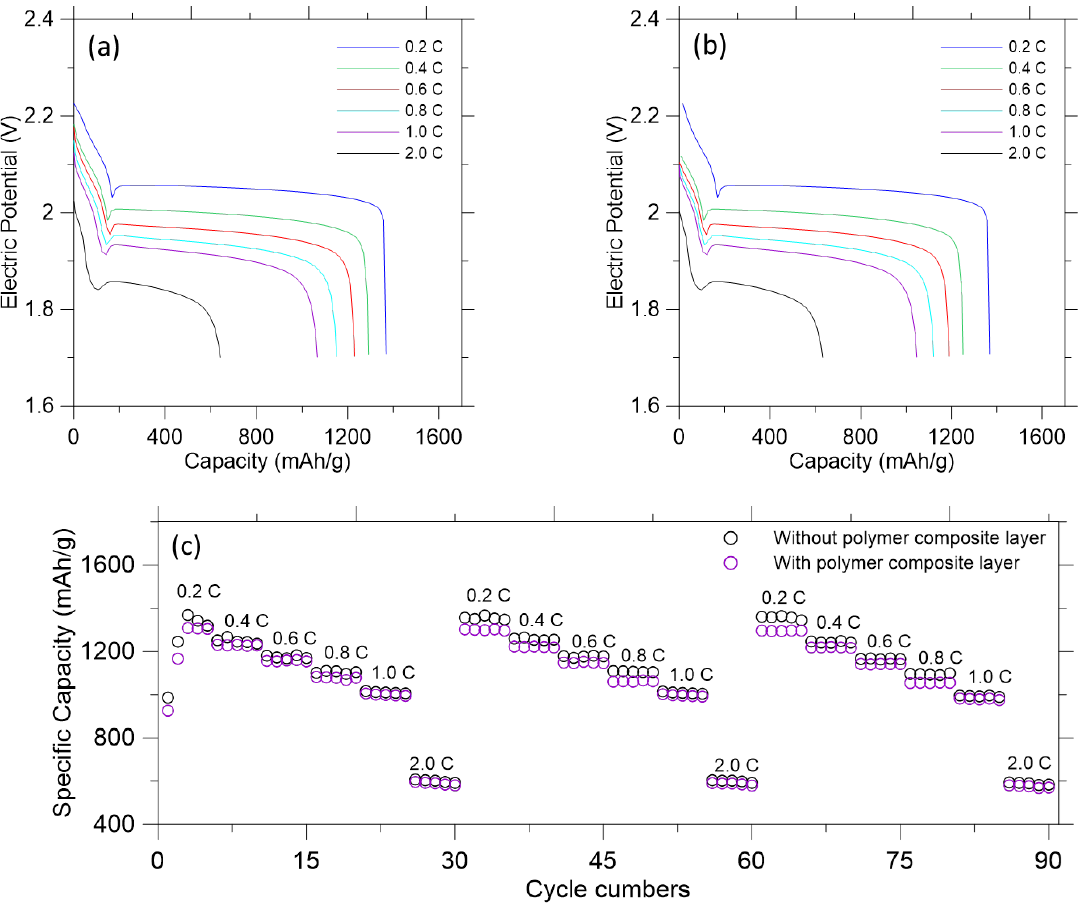
Figure 4. Electrochemical experimental performance of the LISBs. Initial galvanostatic discharge profiles: ( a ) Without the polymer composite layer; ( b ) With the polymer composite layer. ( c ) Rate performance at current density from 0.2 C to 2 C without and with the polymer composite